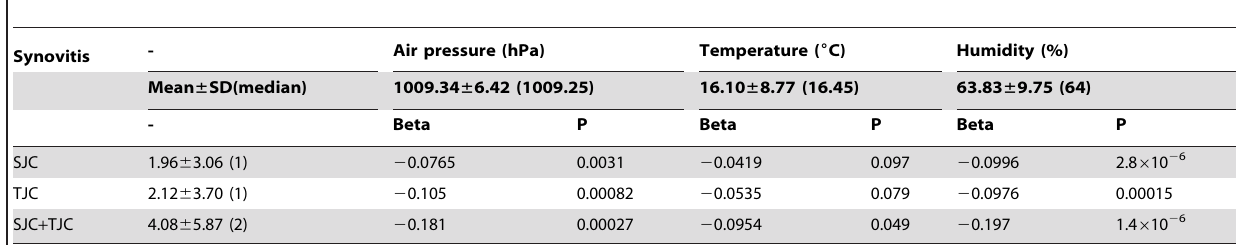
Table 3. Results of multiple standardized linear regression analysis between air pressure and joint synvoitis.